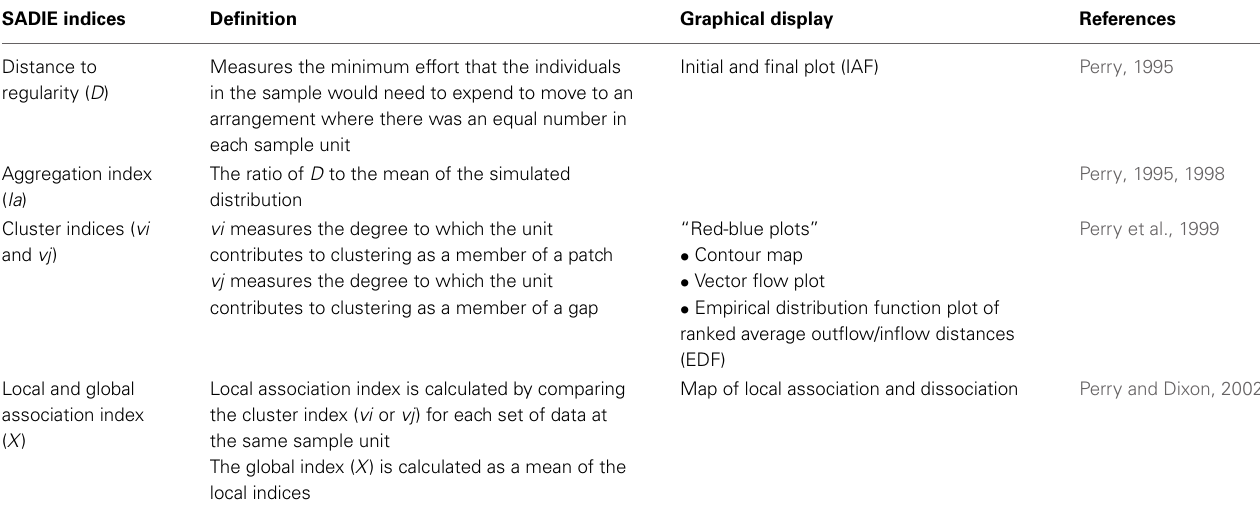
“Red-blue plots” (cid:129) Contour map (cid:129) Vector flow plot (cid:129) Empirical distribution function plot of ranked average outflow/inflow distances